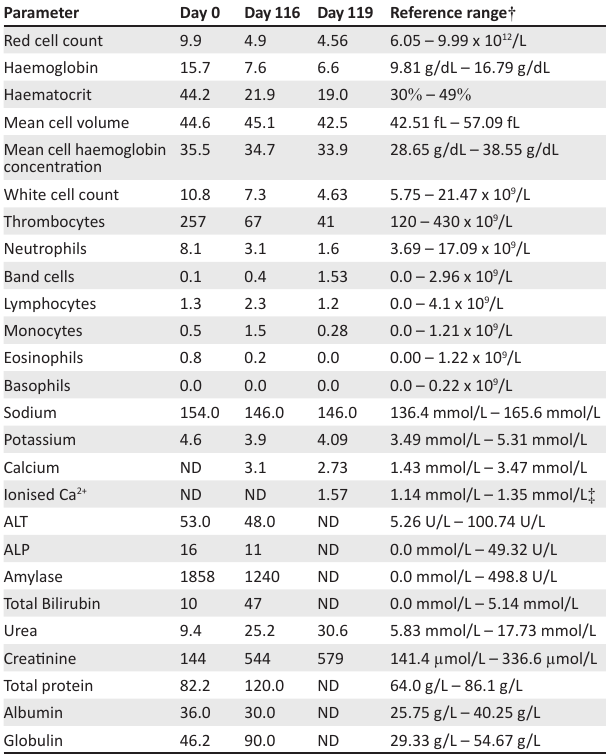
TABLE 1: Haematological and biochemical results.